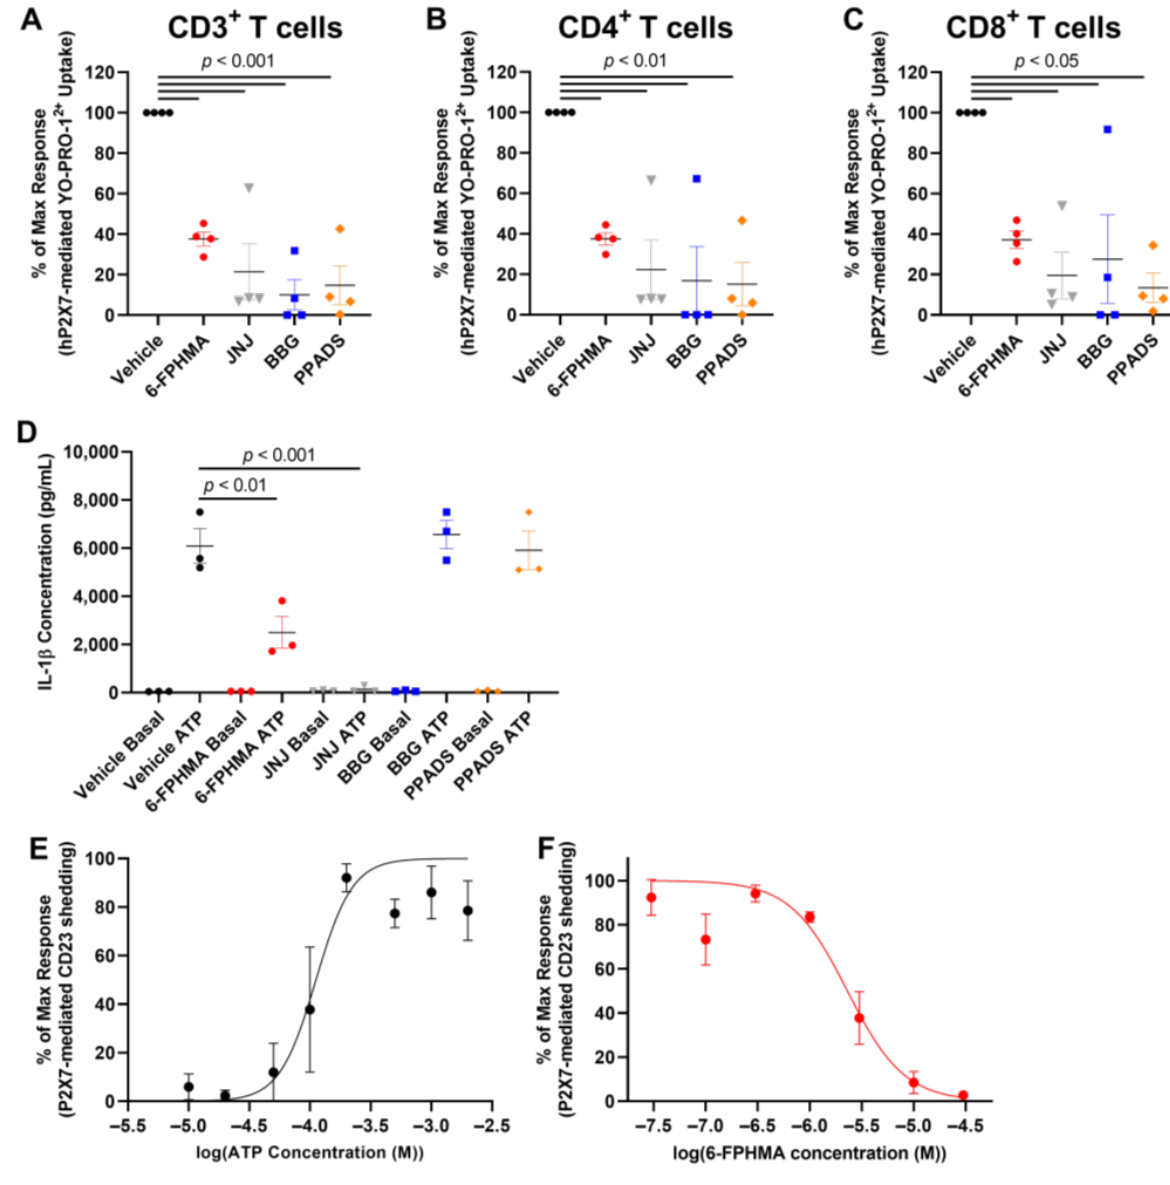
Figure 3. 6-FPHMA inhibits P2X7 on human leukocytes. ( A – C ) Human peripheral blood mononuclear cells (PBMCs) were pre-incubated with DMSO (vehicle) or 30 µ M 6-FPHMA, JNJ-47965567 (JNJ), Brilliant Blue G (BBG) or pyridoxalphosphate-6-azophenyl-2 (cid:48) ,4 (cid:48) -disulfonic acid (PPADS) (15 min), then incubated with YO-PRO-1 2+ in the absence (basal) or presence of 1 mM ATP (5 min). ( A – C ) Cells were stained with anti-CD3, anti-CD4 and anti-CD8 monoclonal antibodies (mAb) and YO-PRO-1 2+ uptake into ( A ) CD3 + , ( B ) CD4 + or ( C ) CD8 + T cells was assessed by flow cytometry. Data were normalised to the maximum ATP response in each experiment. ( D ) Human whole blood was incubated with RPMI-1640 medium containing lipopolysaccharide (105 min), then with DMSO (vehicle) or 30 µ M 6-FPHMA, JNJ, BBG or PPADS (15